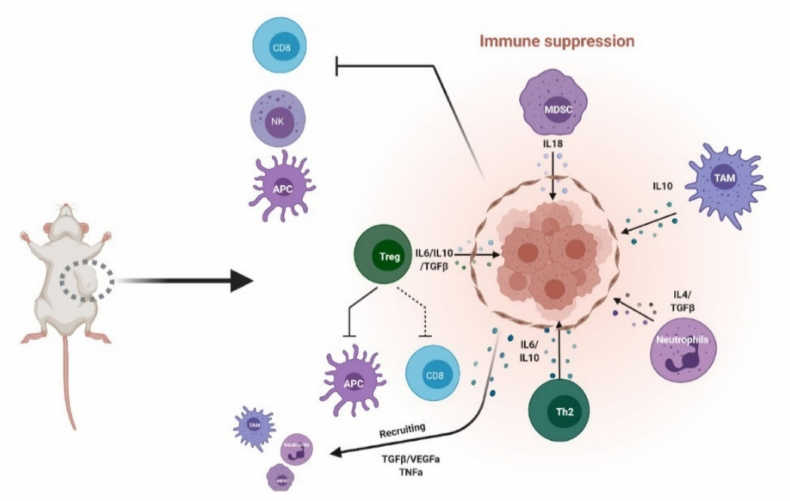
Figure 1. Inhibitory tumor immune microenvironment (iTIME). Schematic of known components of inhibitory TIME. MDSC: myeloid-derived suppressor cells; TAM: tumor-associated macrophages; Th2: helper T cells; Treg: regulatory T cells; NK: natural killer; APC: antigen-presenting cells; CD8: cytotoxic T cells. Created with BioRender.com (accessed on 6 April